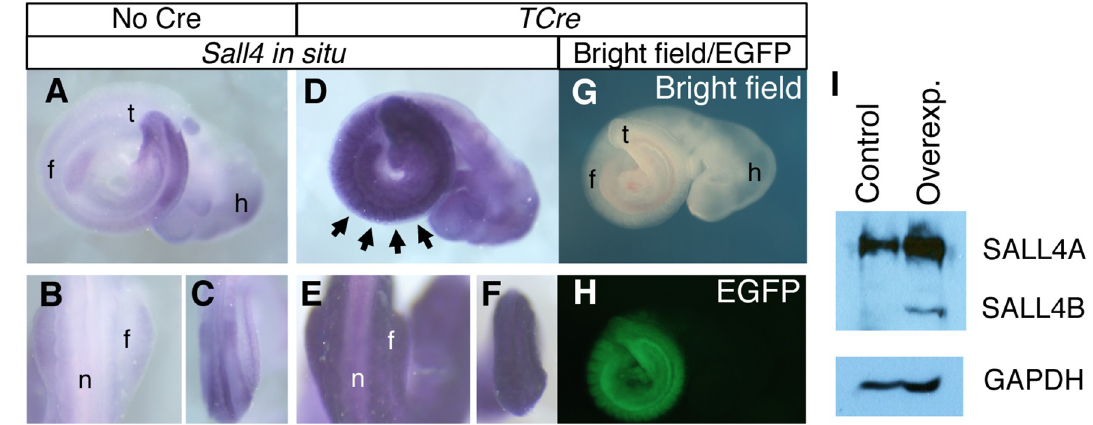
Fig 2. TCre -dependent overexpression of Sall4 . (A-C) Endogenous expression pattern of Sall4 at E9.5. A lateral view of a whole embryo (A), a dorsal view at the forelimb level (B) and a dorsal view of the caudal part of the embryo (C) are shown. (D-F) Sall4 expression in the TCre +/tg ; R26-Sall4 +/tg embryo. A lateral view shows strong expression of Sall4 in the trunk (D). A dorsal view at the forelimb level shows strong expression in the somite and forelimb bud (E). A dorsal view of the caudal part of the embryo shows strong expression in this region (F). (G, H) Lateral views of the TCre +/tg ; R26-Sall4 +/tg embryo. A bright field image (G) and an EGFP image (H) are shown. The EGFP signal is detected in the trunk, similar to strong Sall4 expression in D. (I) Western blotting of lysate from TCre +/+ ; R26-Sall4 +/tg embryos (control) and TCre +/tg ; R26-Sall4 +/tg embryos (overexp.). Stronger bands for SALL4A and SALL4B are detected with extracts from the TCre +/tg ; R26-Sall4 +/tg embryo. Abbreviations. f: forelimb bud, h: head, n: neural tube, t: tail